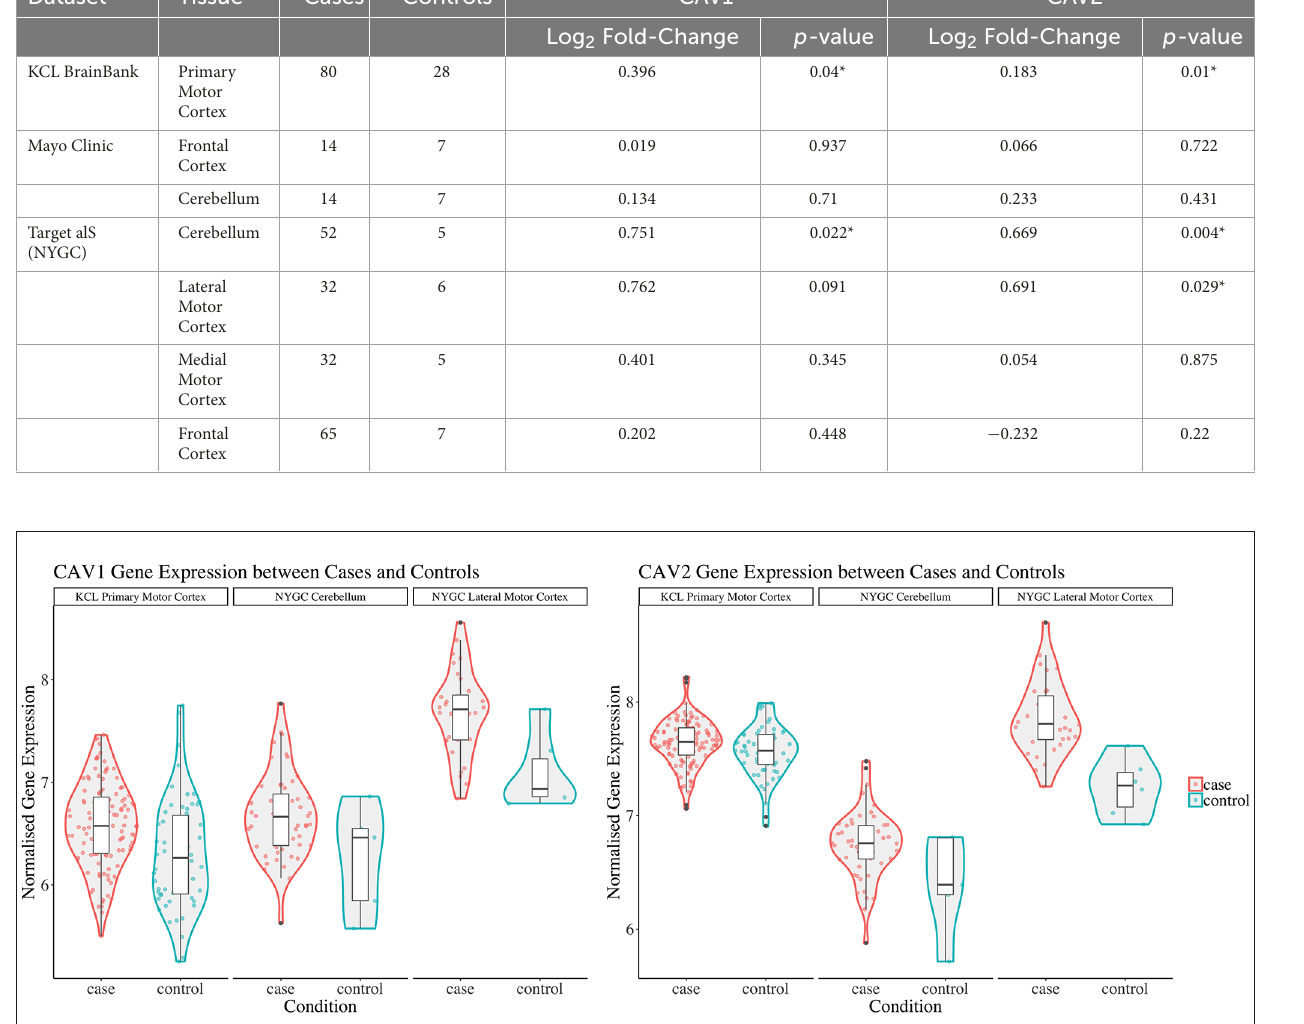
each sample. Boxplots inside each violin plot show gene expression for each category. Violin plot colour: Condition (case: red; control: blue). Note that CAV1 differential expression in the lateral motor cortex is significant only to p < 0.1. Violin plots for all analyses are available in Supplementary